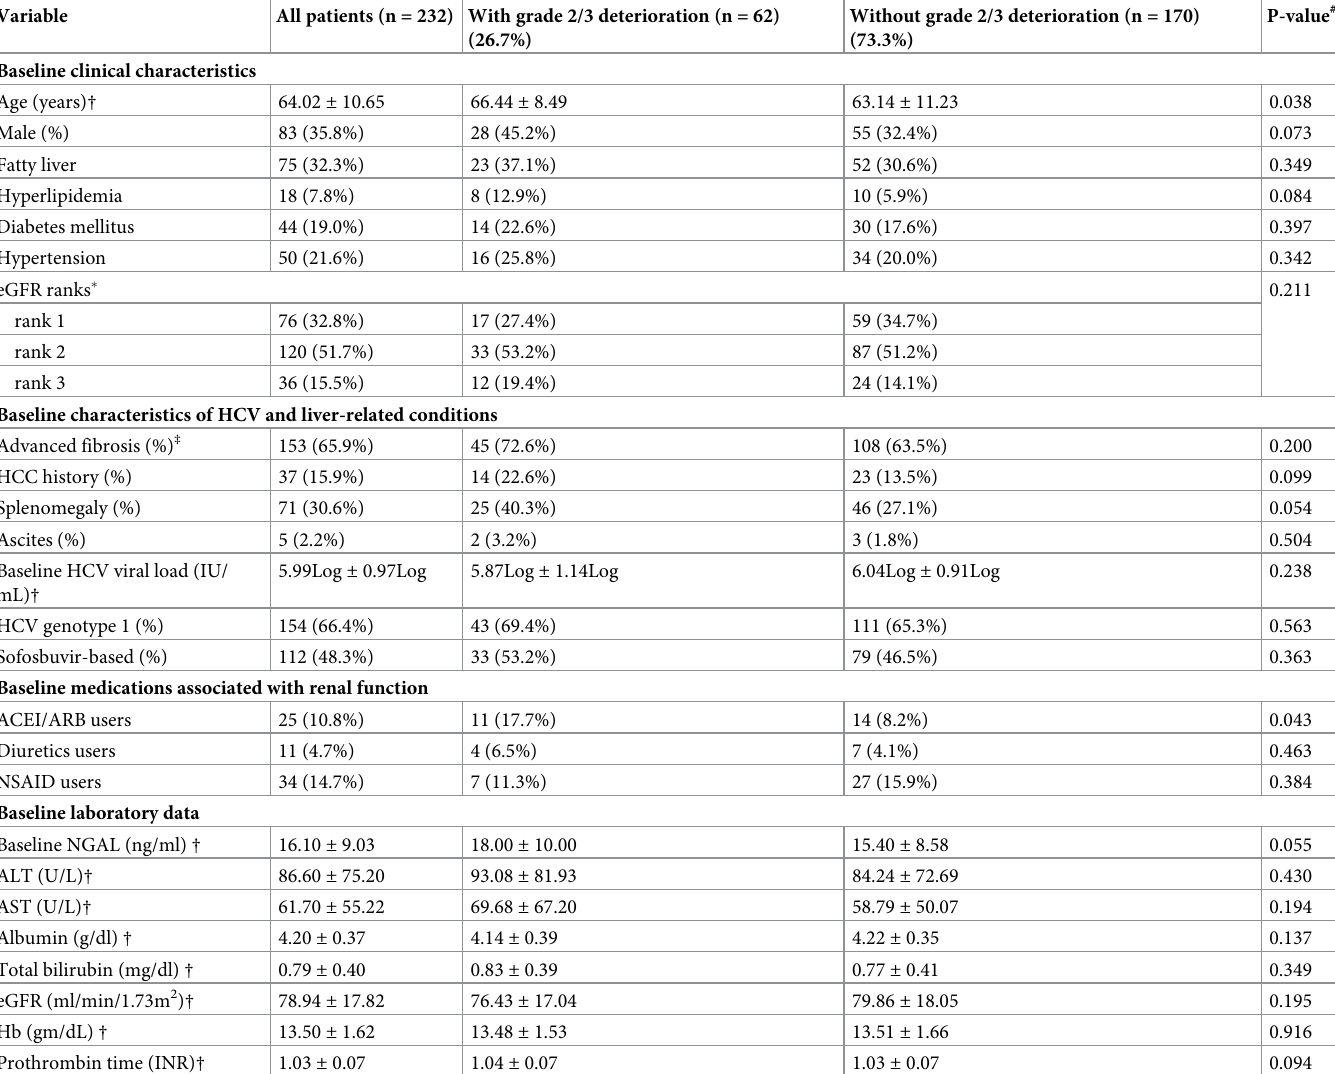
Table 1. Baseline characteristics of chronic hepatitis C patients receiving DAA with or without grade 2/3 renal function deterioration at P12.